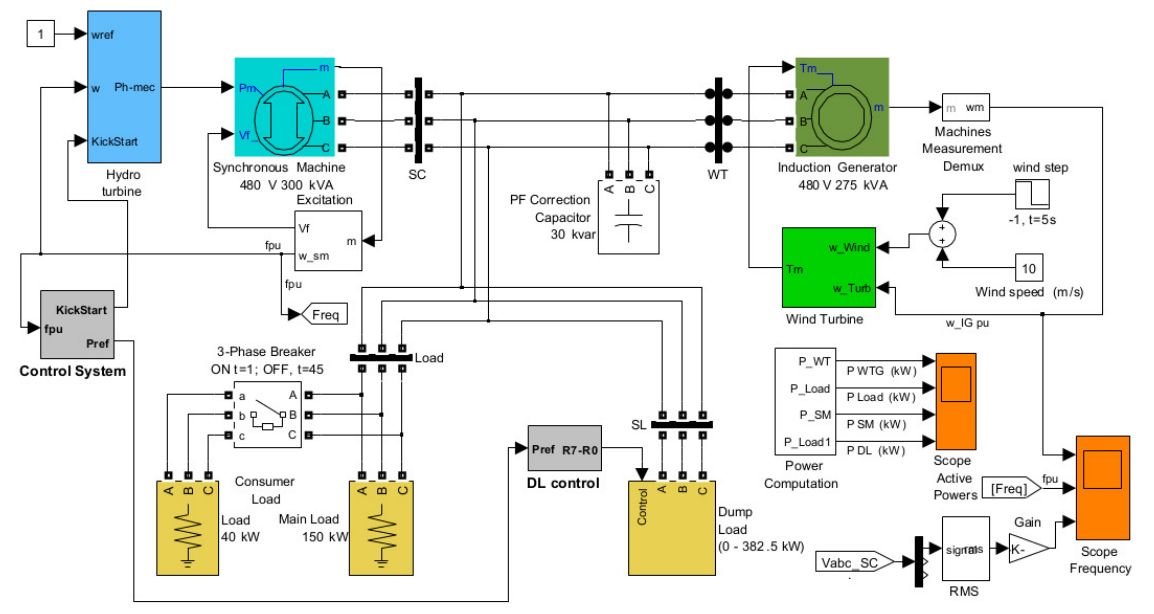
Figure 3. Wind-hydro isolated microgrid Simulink